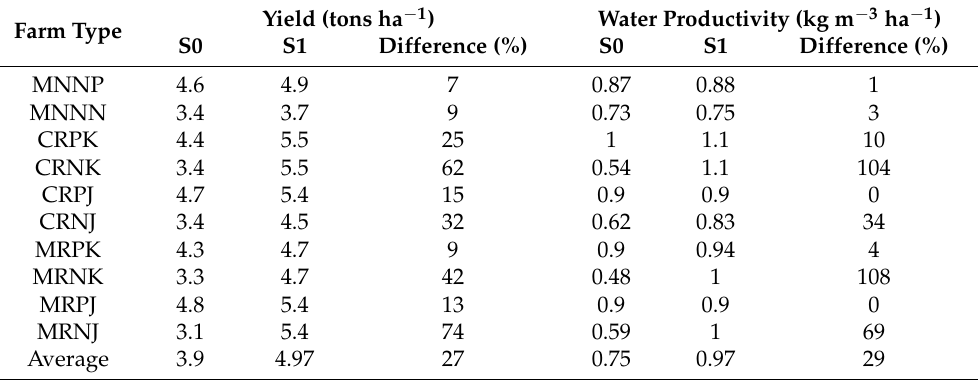
Table 5. Variation in yields and water productivity of DW by farm type and scenario. Farm